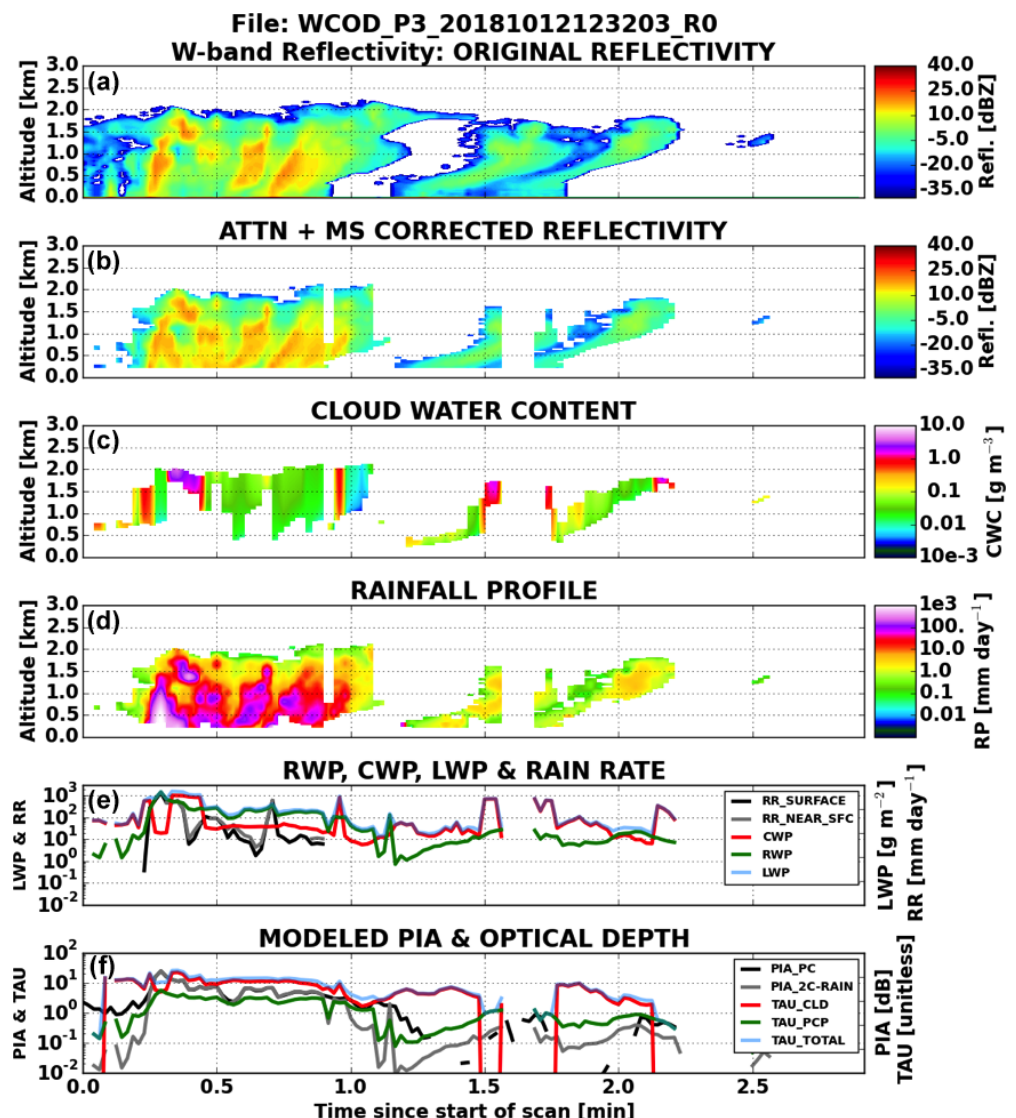
Figure 5. Similar to Fig. 2 but for a heavily precipitating trade cumulus cloud observed by the APR-3 on 12 October 2018.